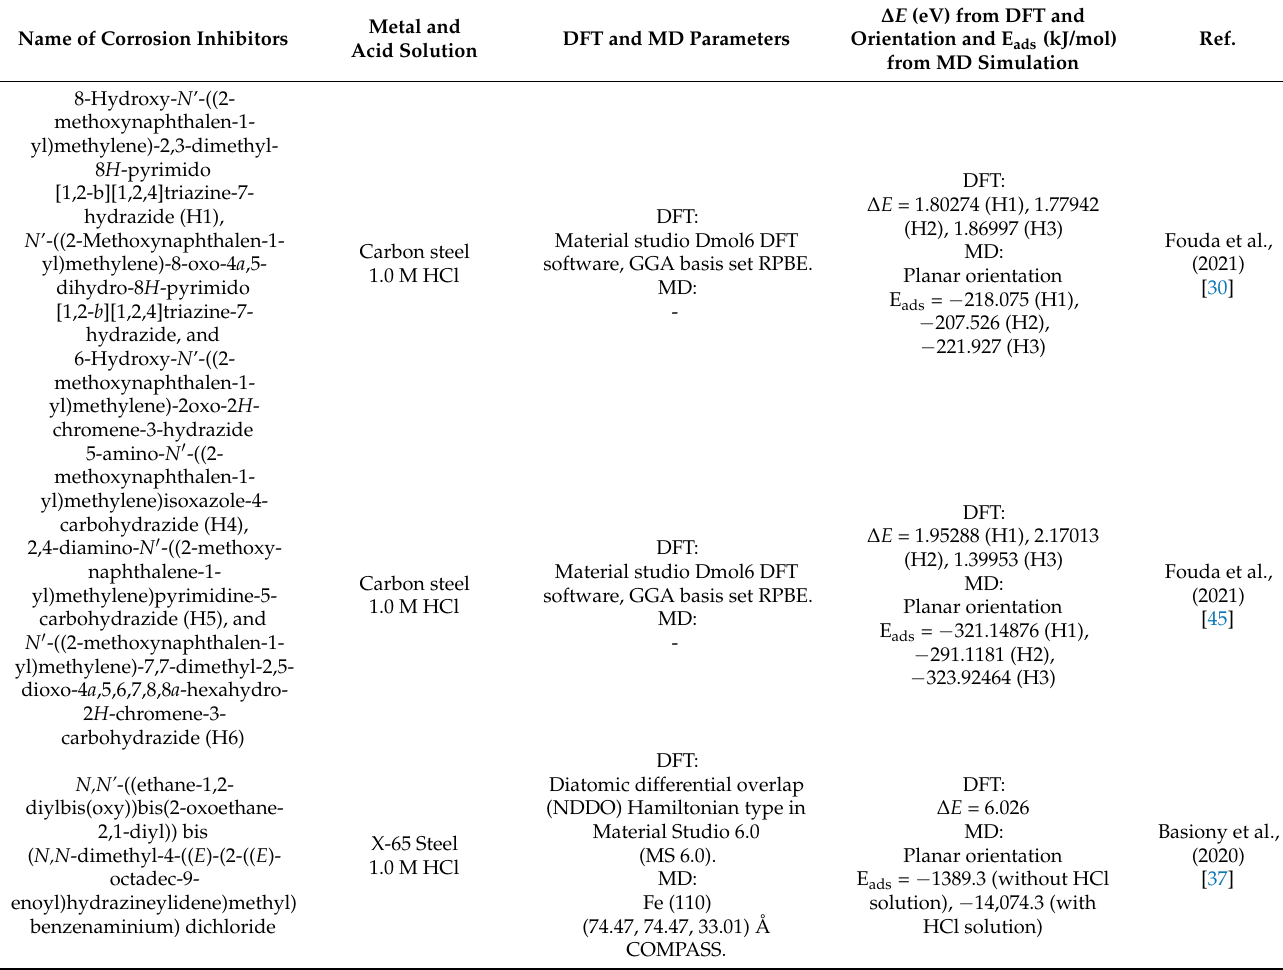
Table 4. Hydrazide derivatives CI, DFT, and MD simulation parameters and